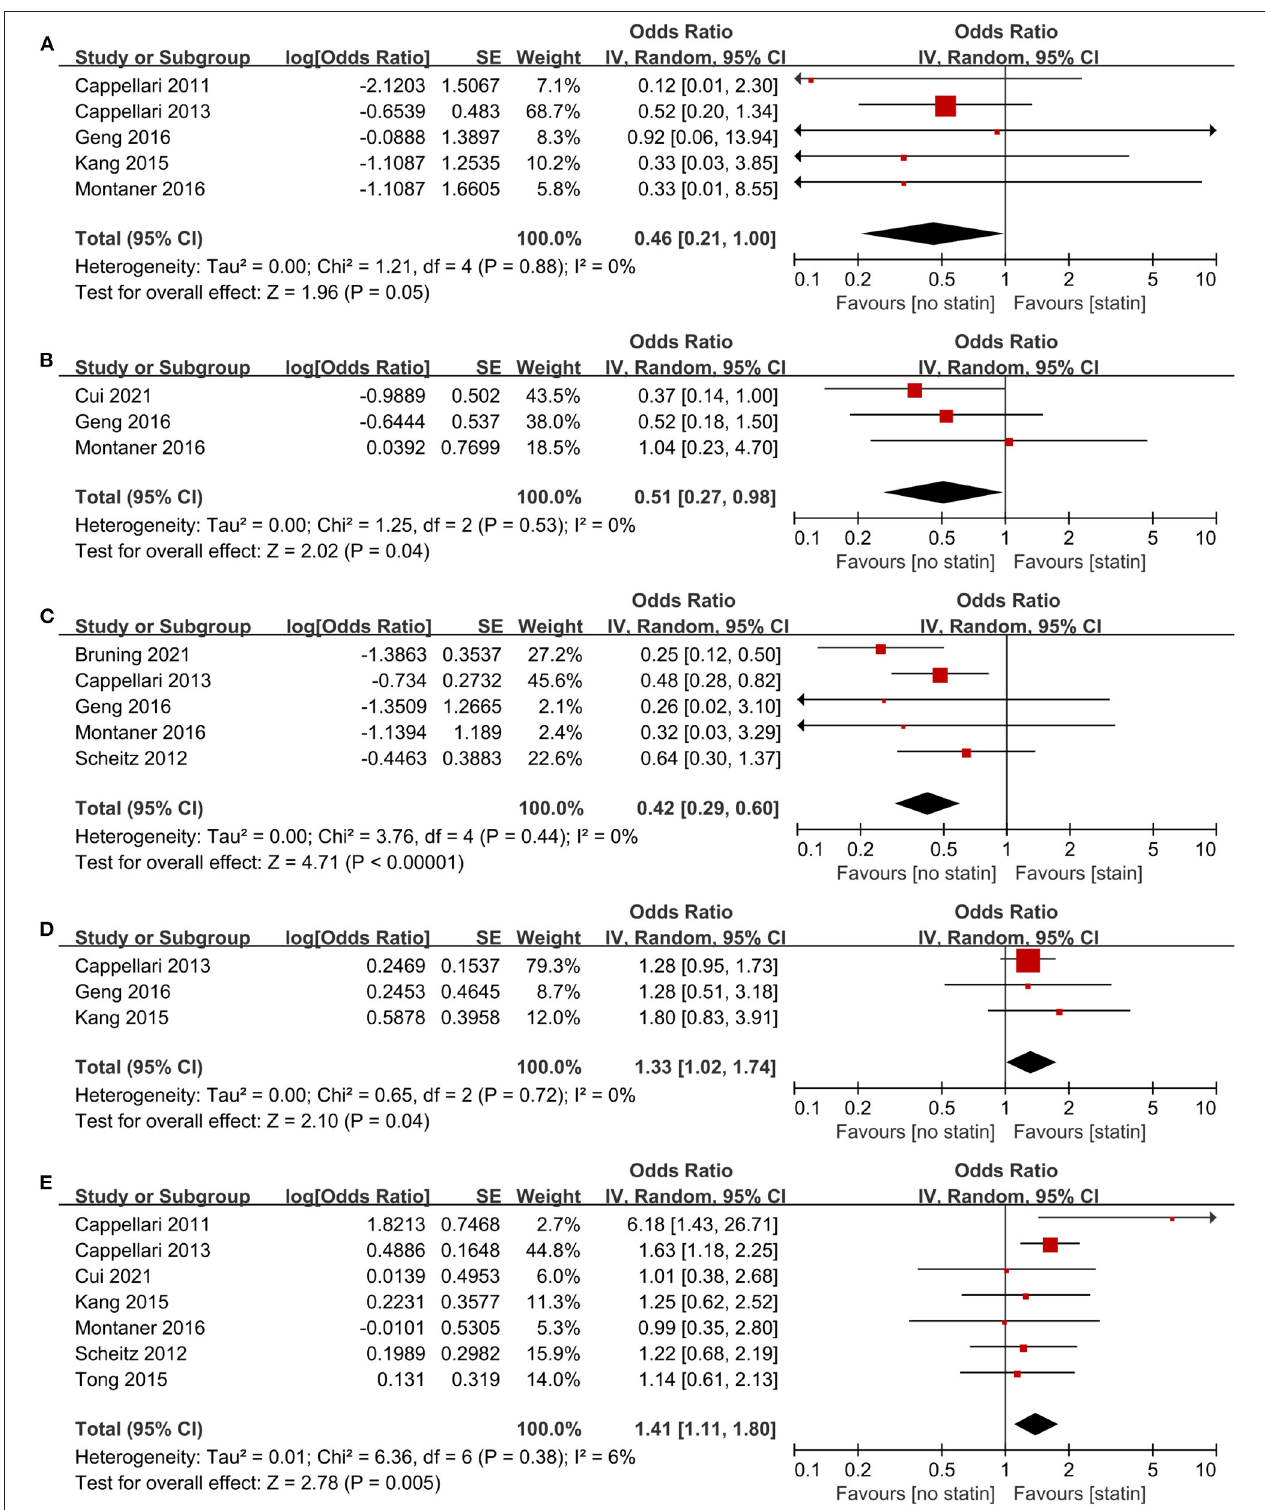
FIGURE 3 | Association of in-hospital statin use with (A) symptomatic intracranial hemorrhage, (B) any intracranial hemorrhage, (C) 3-month mortality, (D) 3-month favorable functional outcome, and (E) 3-month functional independence.